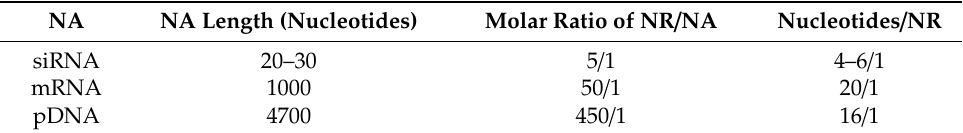
Table 1. Neutralization of nucleic acids (NA) with protamine as neutralization reagent (NR). Shown are the analyzed NAs, their sizes in nucleotides, the most efficient molar ratios of NR/NA as well as the corresponding numbers of nucleotides per NR.